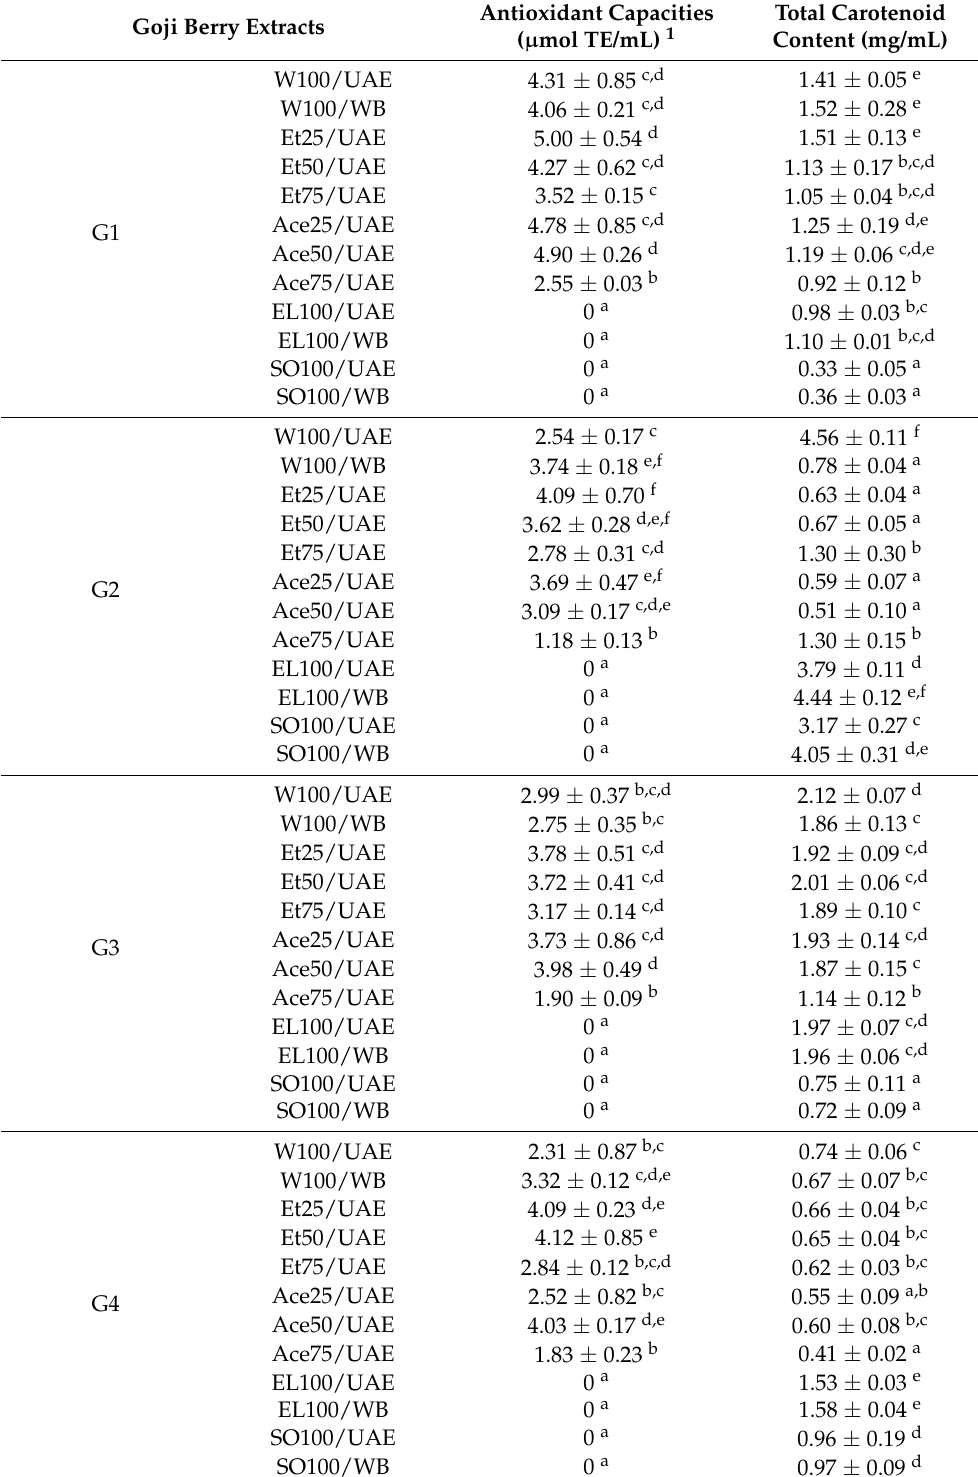
Table 1. Antioxidant capacities and carotenoids content in goji berry extracts: G1—natural dried goji berries from an unspecified region in China; G2—freeze-dried goji berries from Poland;